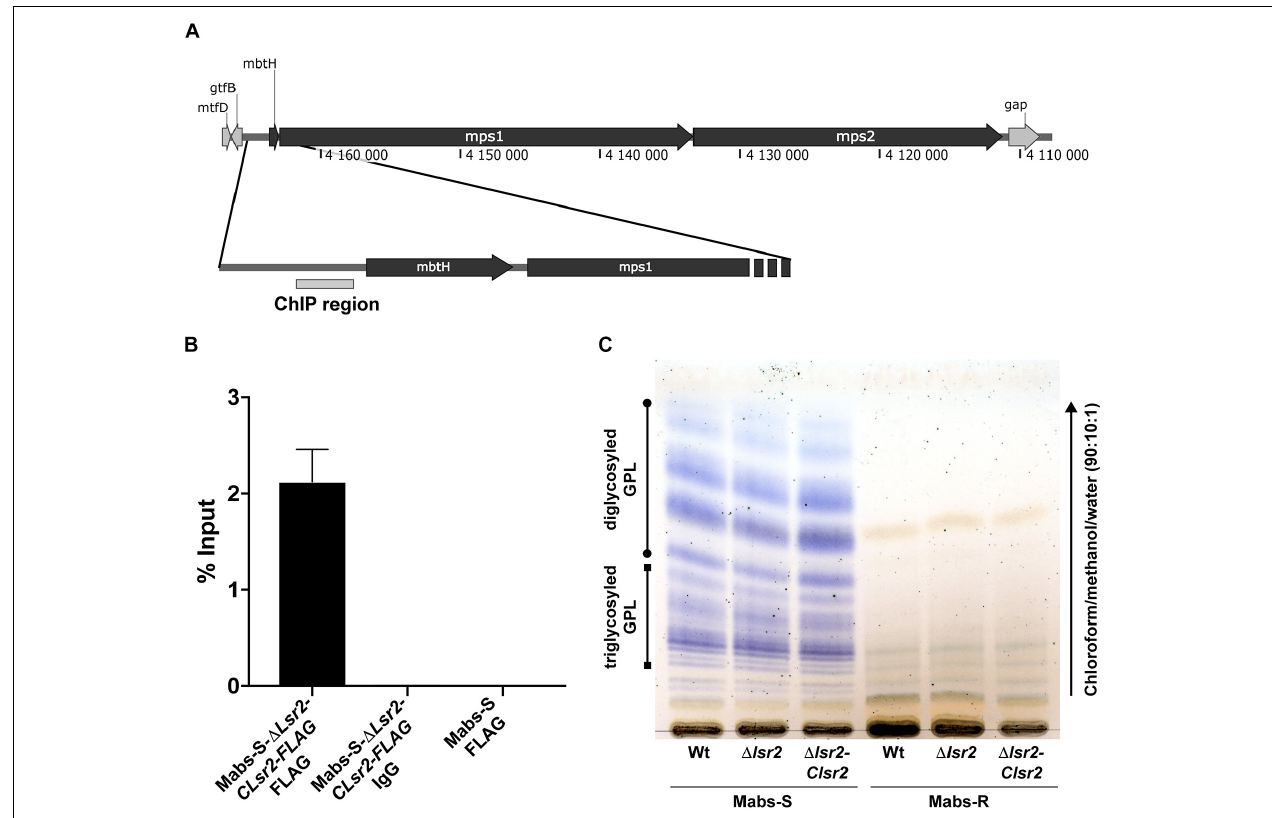
FIGURE 3 | Measurement of Lsr2 enrichment in the promoter region upstream of the mbtH/mps1 genes. (A) Schematic representation of the GPL locus. The gray box upstream of the mbtH gene represents the region used to assay Lsr2 enrichment. (B) qPCR of ChIP performed using an anti-FLAG antibody. Enrichment of Lsr2 bound to the mbtH/mps1 promoter region in Mabs-S- (cid:49) lsr2 - Clsr2-FLAG was calculated using the “percent input” method (% input = 1.894%). Negative controls included in ChIP assays using an unrelated IgG antibody on Mabs-S- (cid:49) lsr2 -C lsr2-FLAG (% input = 0.00274%) and the anti-FLAG antibody on Mabs-S (% input = 0.00049%) confirm the specificity of the results. For each assay, n = 3 and error bars are SEM. (C) GPL profile characterizing the WT and (cid:49) lsr2 and lsr2 complemented strains in both S and R backgrounds. Following extraction, the GPL were separated by thin layer chromatography using chloroform/methanol (90:10, v/v) and revealed with a treatment of the TLC plate with a mist of 0.2% of Anthrone in concentrated sulfuric acid and